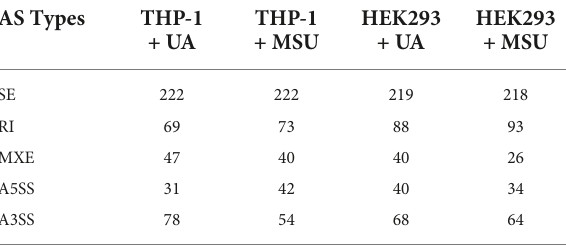
TABLE 2 Genome-wide analysis of RNA alternative splicing in MSU- or UA-treated cell lines. AS Types